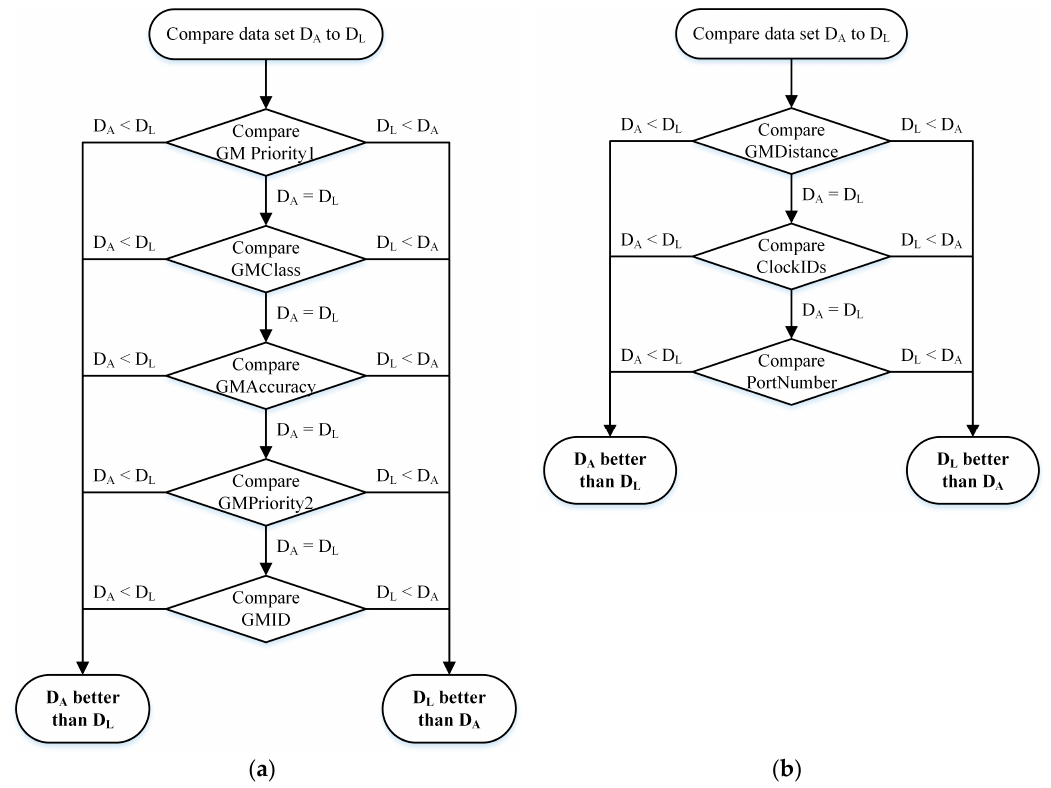
Figure 2. The dataset comparison algorithms for two datasets in two cases. ( a ) Different GM clocks; and ( b ) the same GM clock.